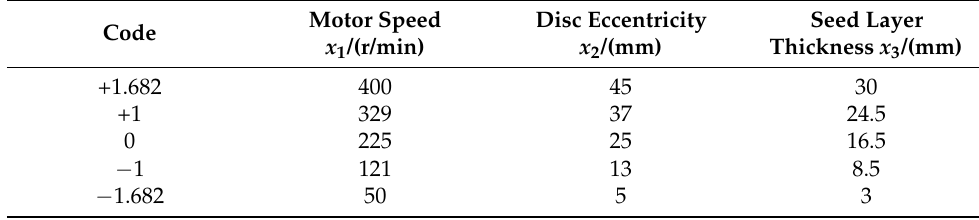
Table 1. Code of test